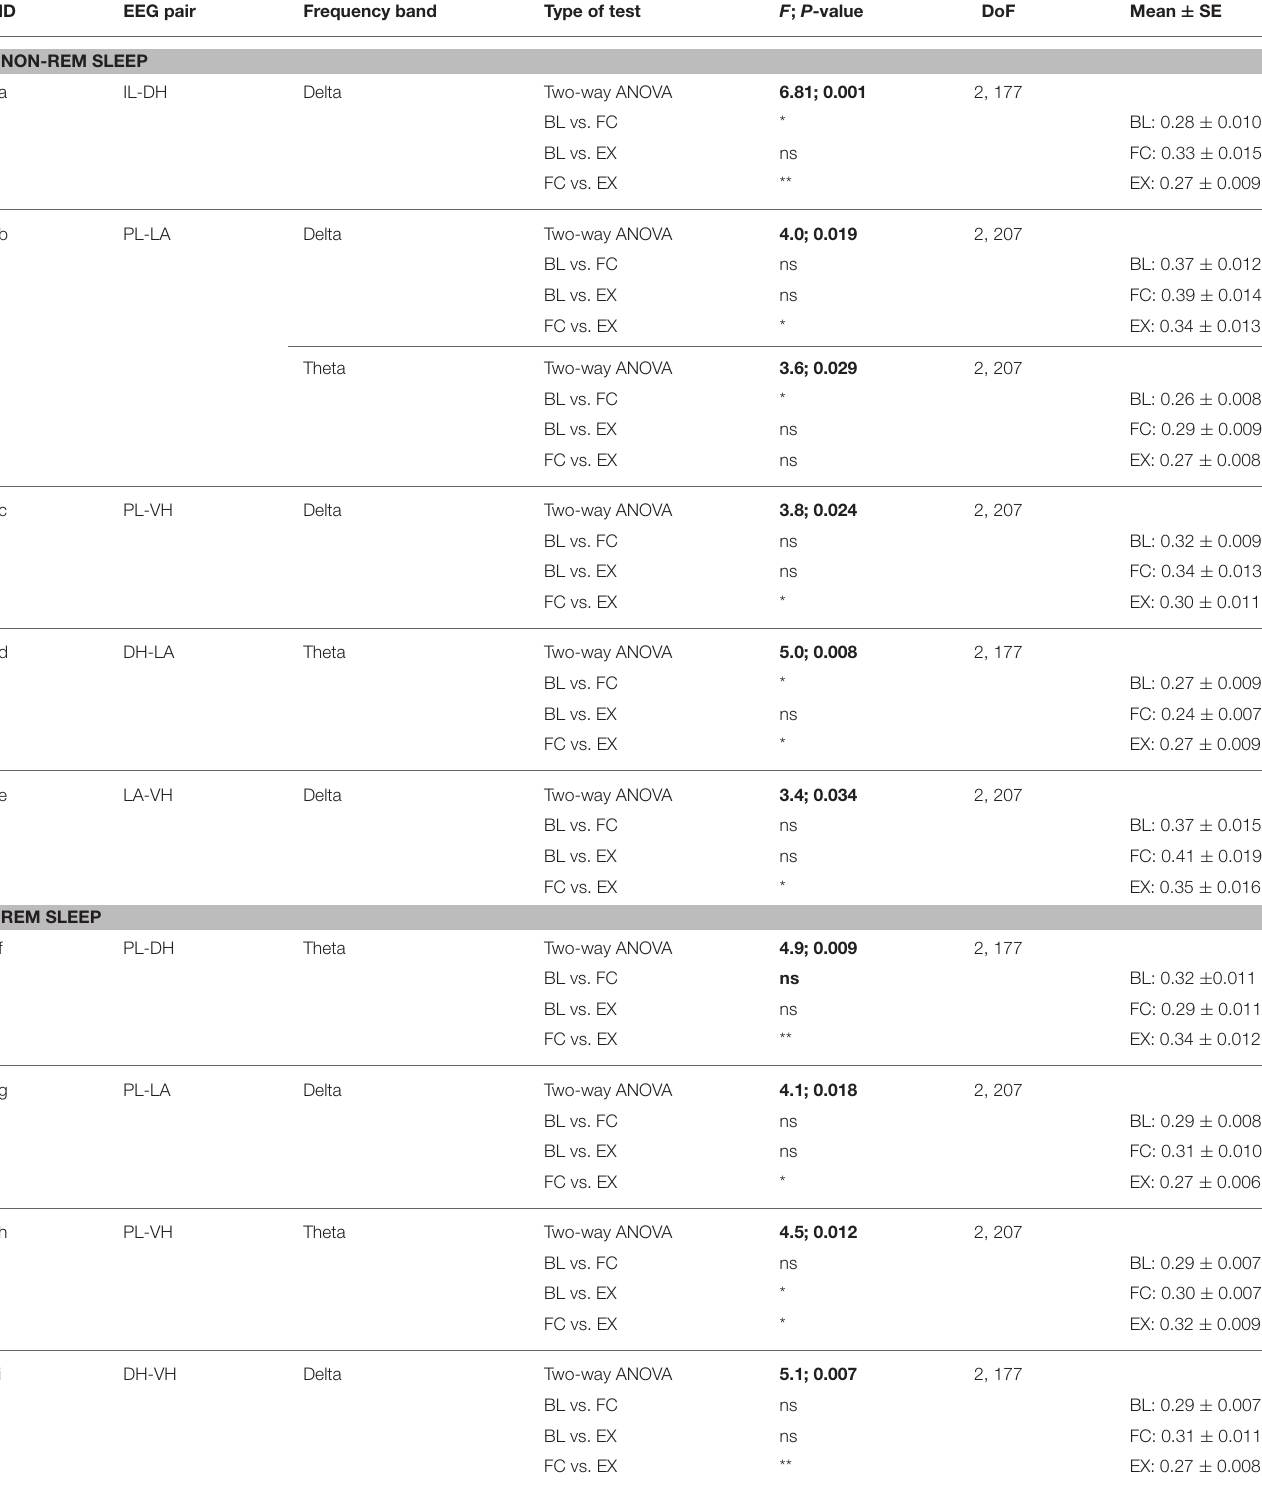
TABLE 2 | Significant changes in delta and theta synchrony in non-REM and REM